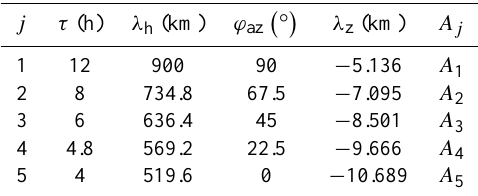
Table 2b. Same as Table 2a, but for 90 ◦ azimuth spreading only.